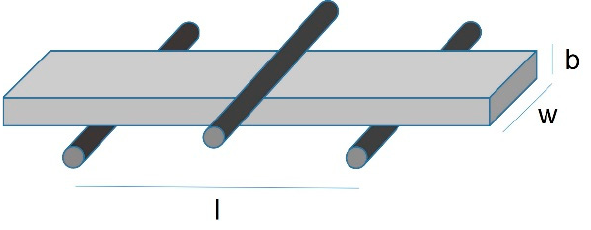
Figure 1. Schematic representation of the 3-PBT flexural strength testing setup.